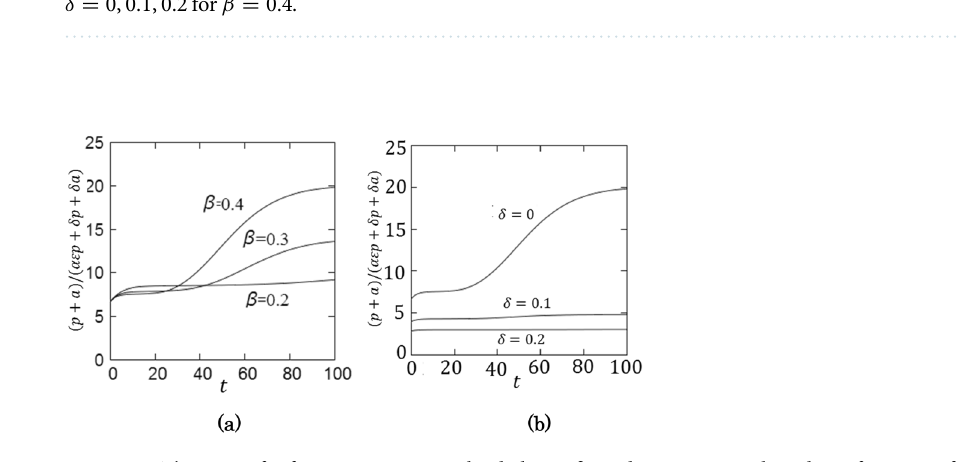
Figure 4. The ratio of infectious patients to the daily confirmed new cases is plotted as a function of time. ( a ) β = 0.4 , 0.3, 0.2 for δ = 0.0 and ( b ) δ = 0, 0.1, 0.2 for β = 0.4